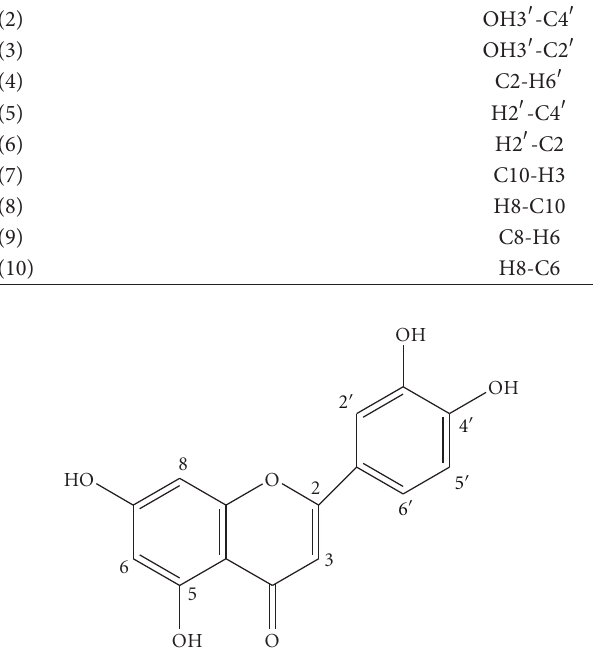
F 1: Structures of 5,7-dihydroxy-2-(3,4-dihydroxyphenyl)- 4H-chromen-4-one.